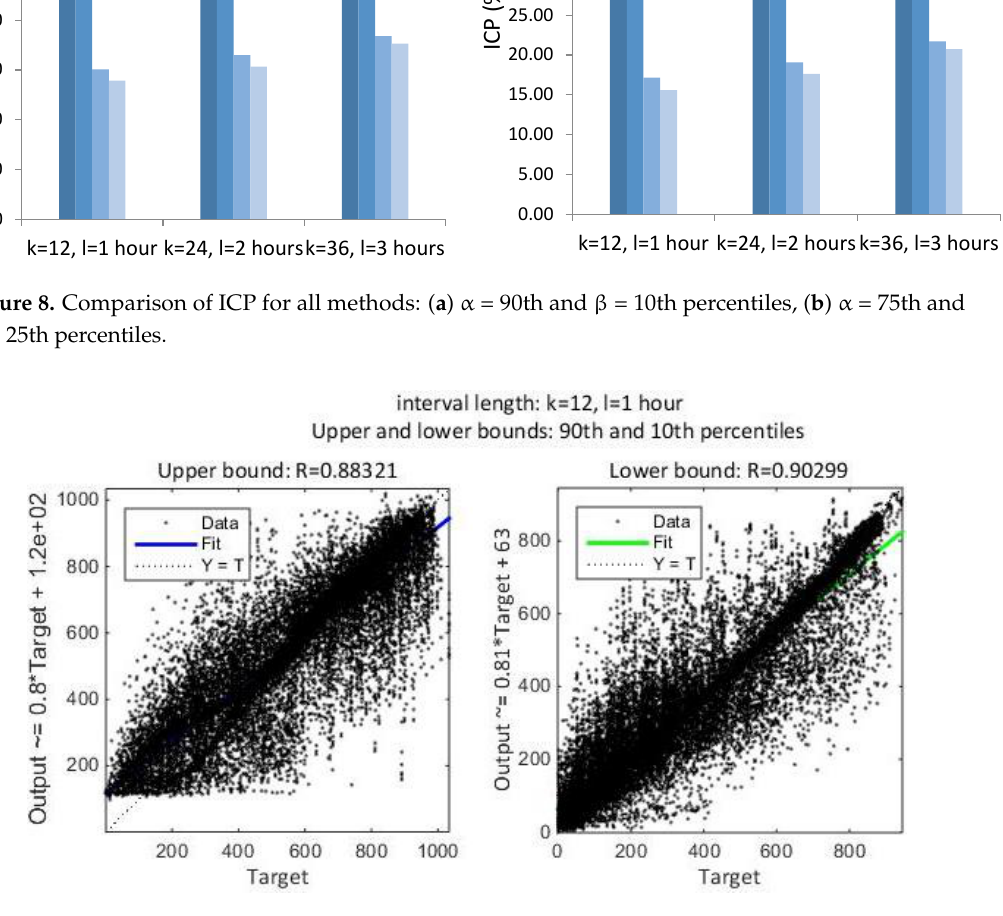
Figure 9. Regression plots of actual and predicted values for the intervals with length 30 min, and α = 90th and β = 10th percentiles.